Question: Generate an informative caption for the figure above.
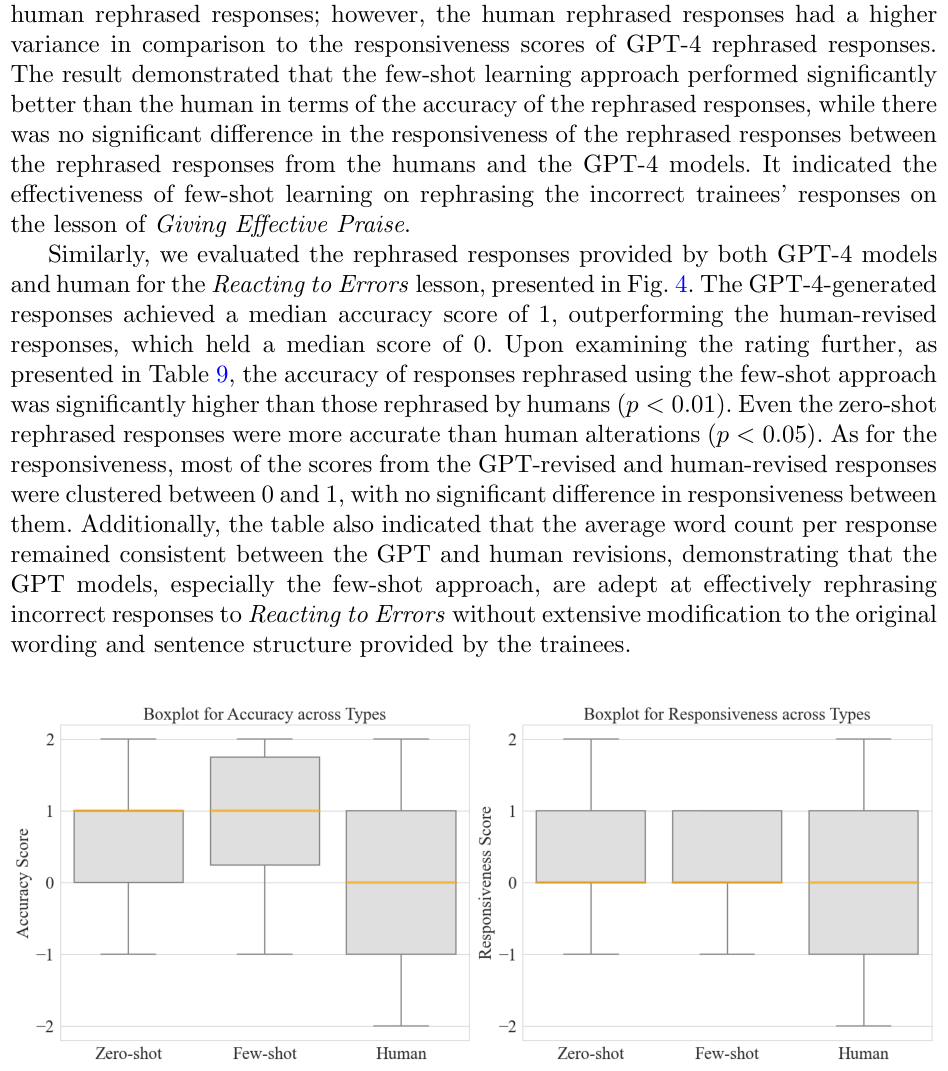
Answer: Distribution of accuracy and responsiveness scores from the lesson Reacting to Errors